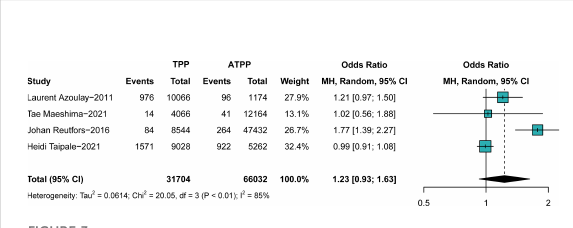
FIGURE 3 The difference in the prevalence of breast cancer between those exposed to typical antipsychotics or atypical antipsychotics. Point sizes are an inverse function of the precision of the estimates, and bars correspond to 95% CIs. TPP, typical antipsychotics; ATPP, atypical antipsychotics.